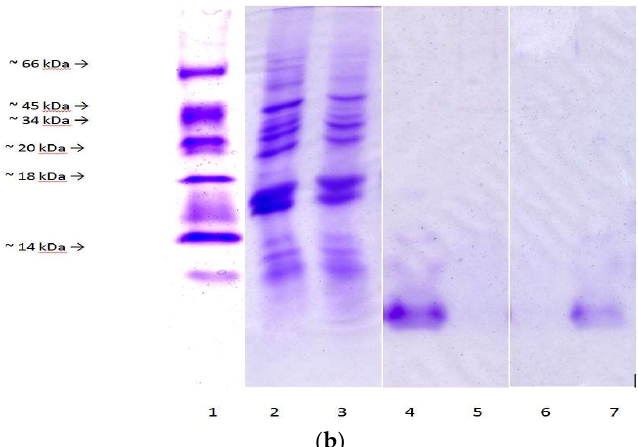
Figure 3. ( a ) Degree of hydrolysis (DH) of apricot oil cake protein isolates obtained by cold pressing (CP) and supercritical fluid extraction (SFE) during in vitro digestion first by pepsin 120 min and then with pancreatin during next 120 min. Values represent the mean±standard deviation (SD) of n = 3 replicate analysis; ( b ) SDS-PAGE analysis of apricot oil cake protein isolates obtained by cold pressing (CP) (line 2) and supercritical fluid extraction (SFE) (line 3) and their products of in vitro digestion.